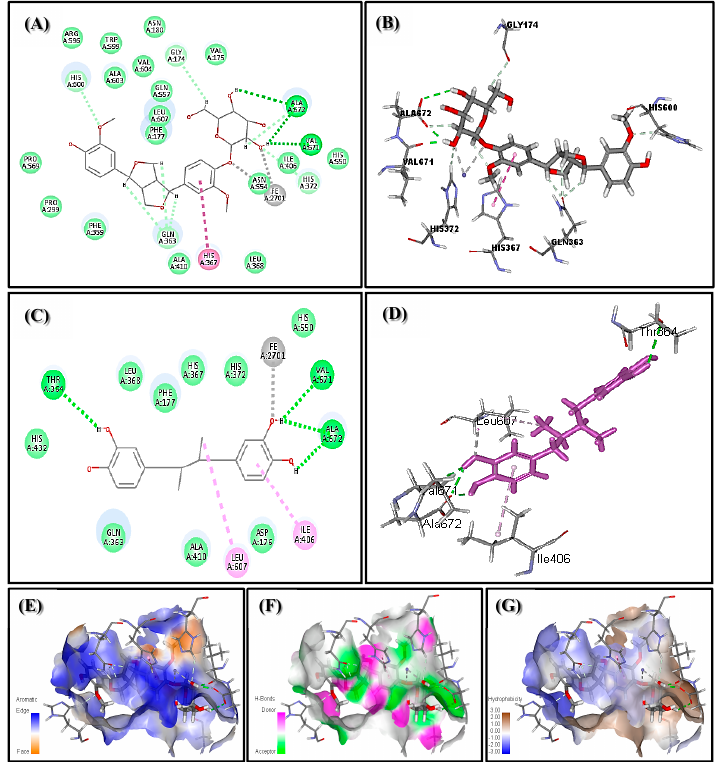
Figure 7. 2-D ( A ) and 3-D ( B ) binding modes of PGu and 2-D ( C ) and 3-D ( D ) binding modes of nordihydroguaiaretic in 5-lipoxygenase (5-LOX ) active sites and the presence of PGu in the active pocket of the receptor showing the aromatic regions ( E ), regions of hydrogen bond formation ( F ), as well as hydrophobicity regions ( G ) in 5-LOX. These results were further consolidated by the in vitro antioxidant activity assessment using the DPPH scavenging capacity assay displaying an IC 50 of 44.2 μ g/mL. Additionally, lignans significantly inhibit the ability of many transition elements, exemplified by copper and iron triggering free radical chain reactions via the formation of complexes through their adjacent –OH moieties or extra chelating groups [25,26]. Regarding the histological manifestation of the neuronal structure, it was found that pilocarpine exerts a massive cellular destruction that effectively participates in epileptogenesis. It induces neuronal damage, as evidenced by the appearance of nuclear pyknosis, shrinkage of the